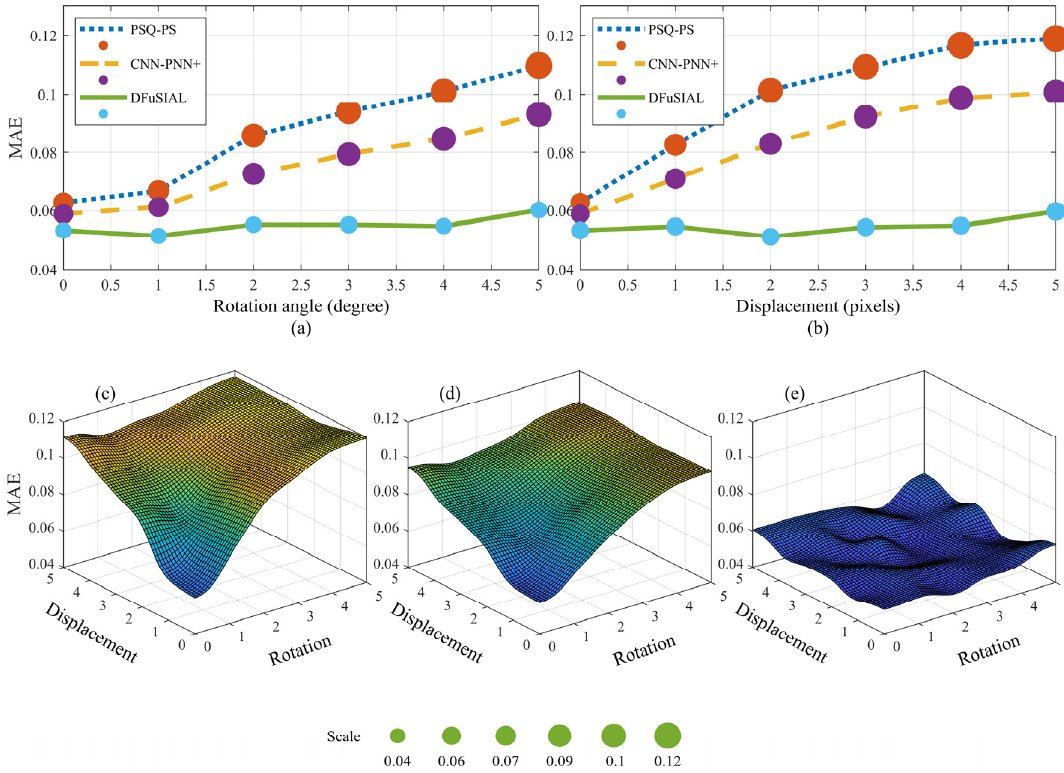
Figure 20. MAE and STD values for the results obtained by PSQ-PS (dotted blue line), CNN-PNN+ (dashed orange line), and DFuSIAL (continuous green line) for different levels of ( a ) radial (rotation) and ( b ) displacement mismatches. ( c ), ( d ), and ( e ) present the MAE surface for the results obtained by PSQ-PS, CNN-PNN+, and DFuSIAL, respectively, created through a 2 D interpolation over the observed values in the 36 cases of radial and displacement mismatch. The size of the dots indicates the value of the STD. The green dots and their corresponding numbers at the bottom of the figure provide a scale for estimating the STD values in the graphs.